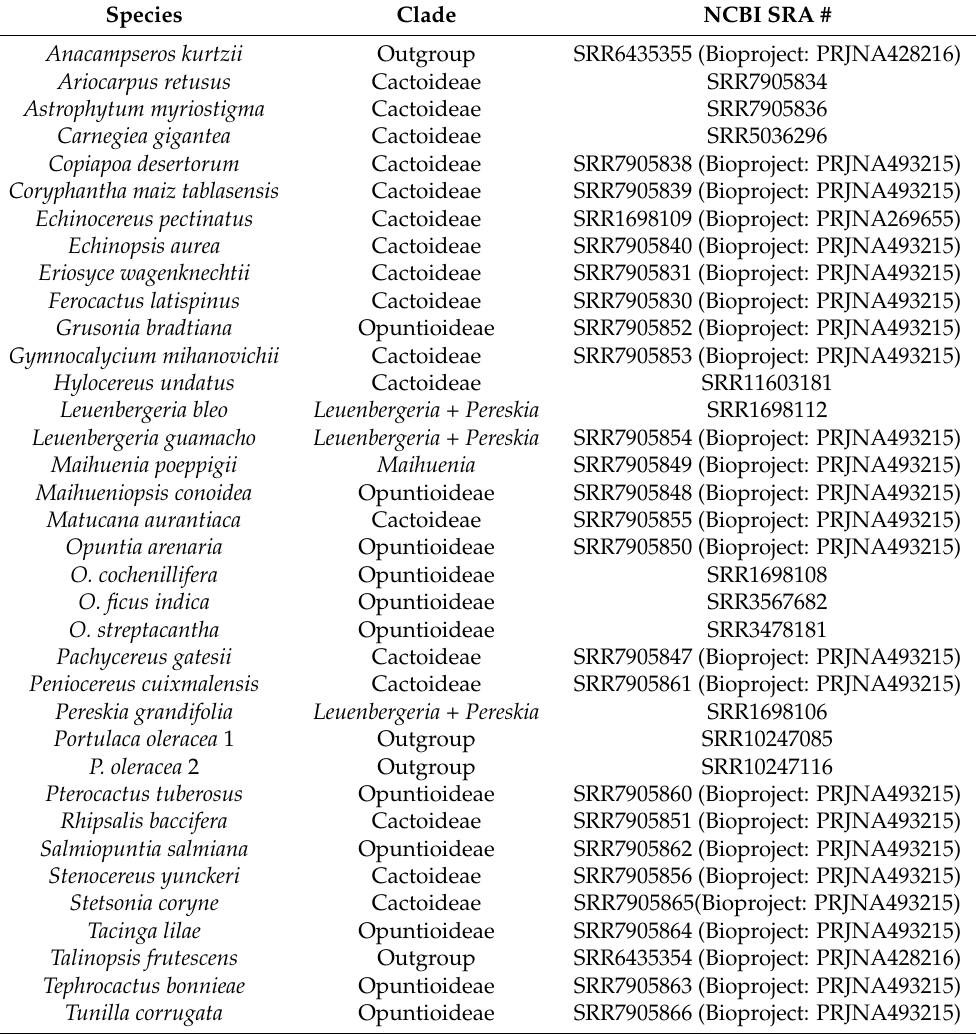
Table 1. Transcriptomes used for phylogenetic reconstruction in this